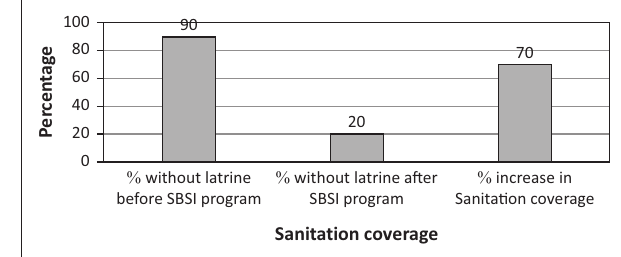
FIGURE 6: Status of selected villages after Subsidy Based Sanitation